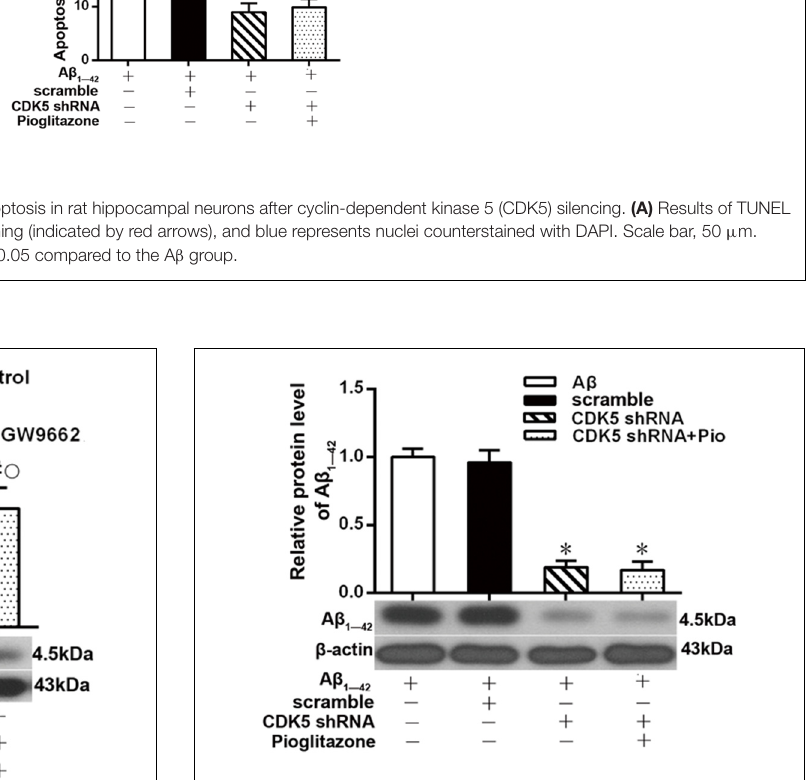
FIGURE 3 | Effects of pioglitazone on the levels of A β 1–42 in Alzheimer’s disease (AD) model neurons. n = 6 wells per group. ∗ P < 0.05 compared to the control group, # P < 0.05 compared to the A β group, ◦ P < 0.05 compared to the Pio group.